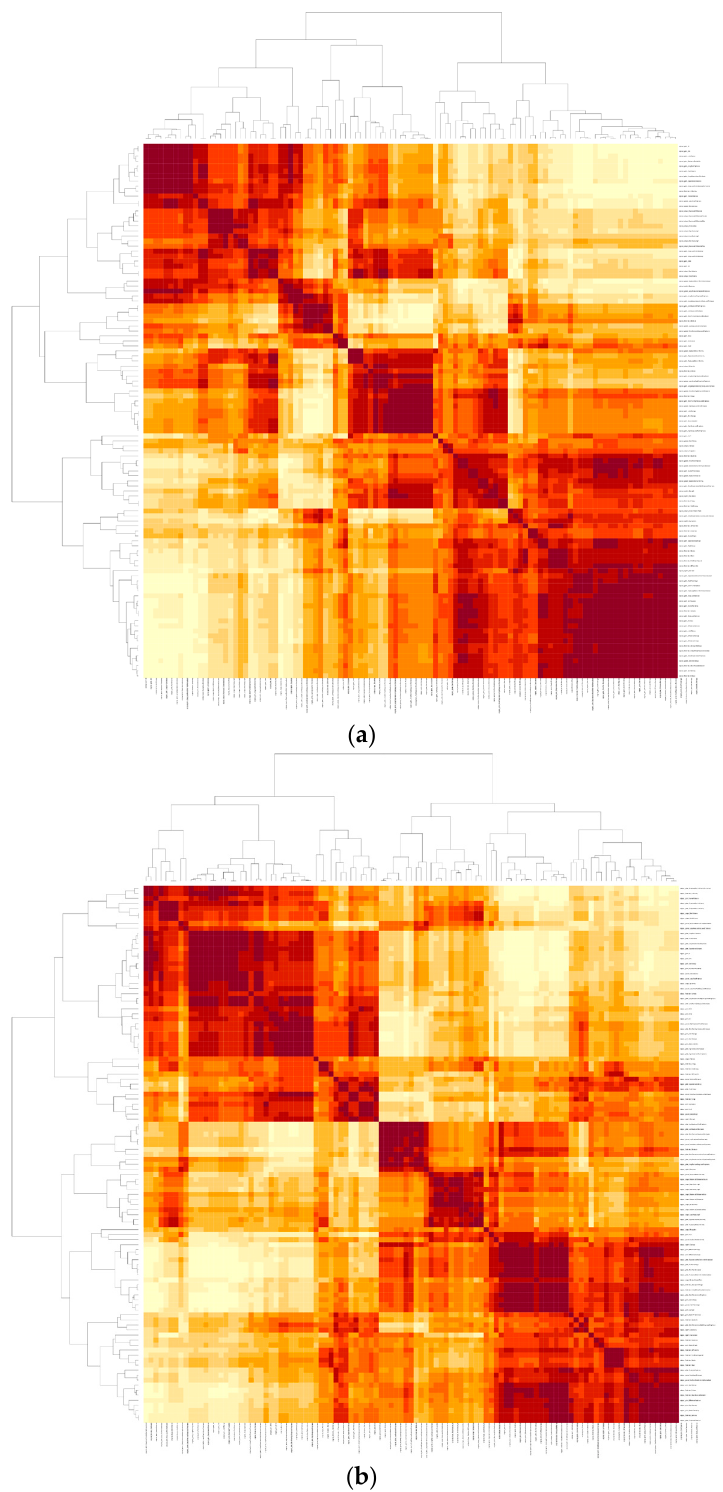
Figure 3. Unsupervised clustering of radiomics features. ( a ) Heatmap for energy-integrating CT (EICT). ( b ) Heatmap for photon-counting CT (PCCT).